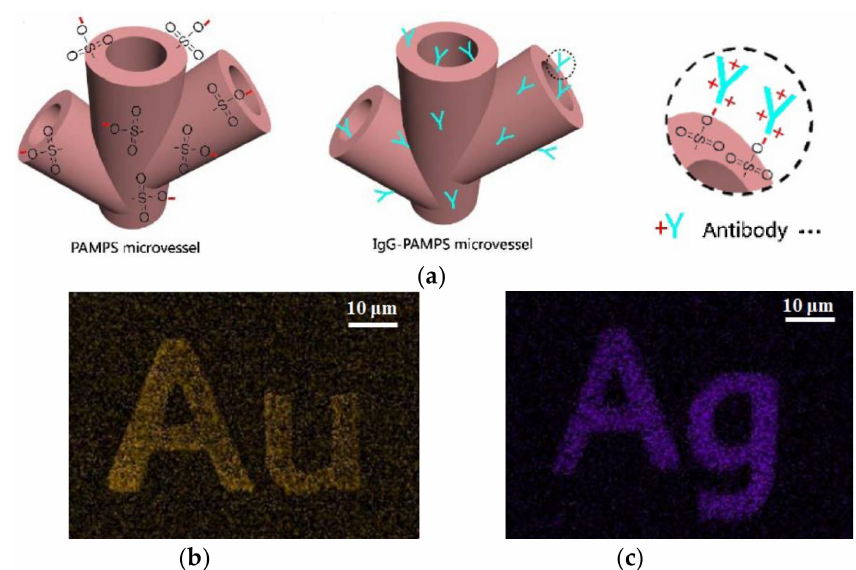
Figure 27. ( a ) Schematic diagram of electrostatic adsorption of 3D PAMPS microvessels with positively charged and positively charged IgG antibodies; ( b ) positively-charged Au nanorods adsorbed on a negatively charged “Au” PAMPS pattern; and ( c ) negatively-charged Ag nanosheets adsorbed on a positively charged “Ag” PAMPS pattern